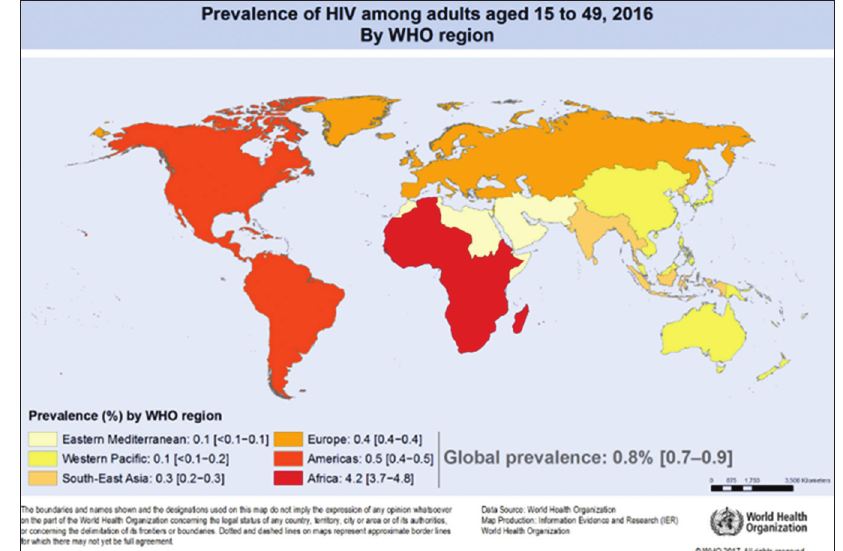
Figure 1: HIV prevalence among adults by WHO